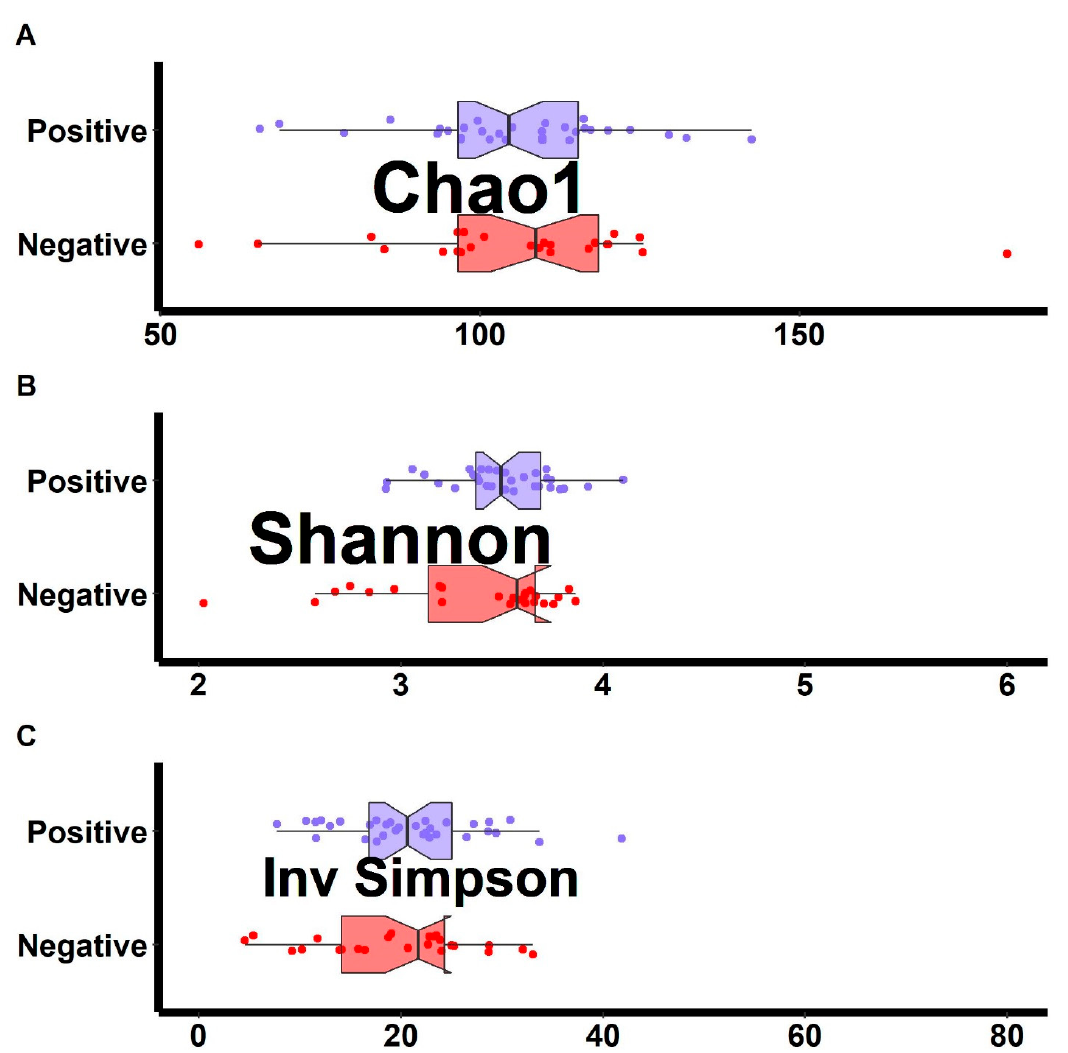
Figure 1. Alpha diversity measures comparing HLA-B27+ to HLA-B27- offspring of AS patients. The Chao1 measure of richness ( A ) along with the Shannon ( B ) and inverse Simpson measures of evenness ( C ) are shown.